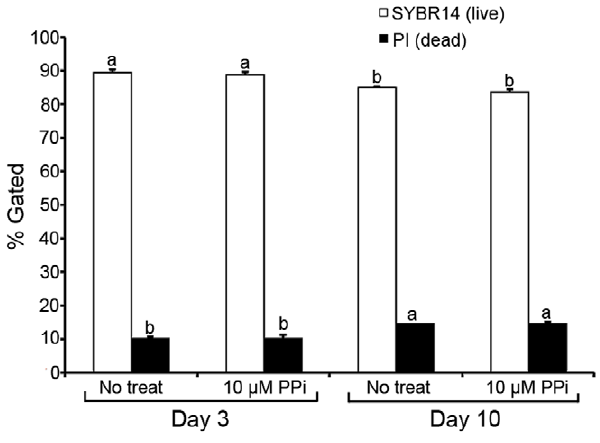
Figure 6. Sperm viability during sperm storage with/without PPi. Percentages of viable spermatozoa are based on dual SYBR14 (live sperm) and PI (dead sperm) labeling. Experiments were repeated three times. Values are expressed as the mean percentages 6 SEM. Different superscripts a & b in histogram denote significant differences at p , 0.05, meaning that column a is significantly different from column b.